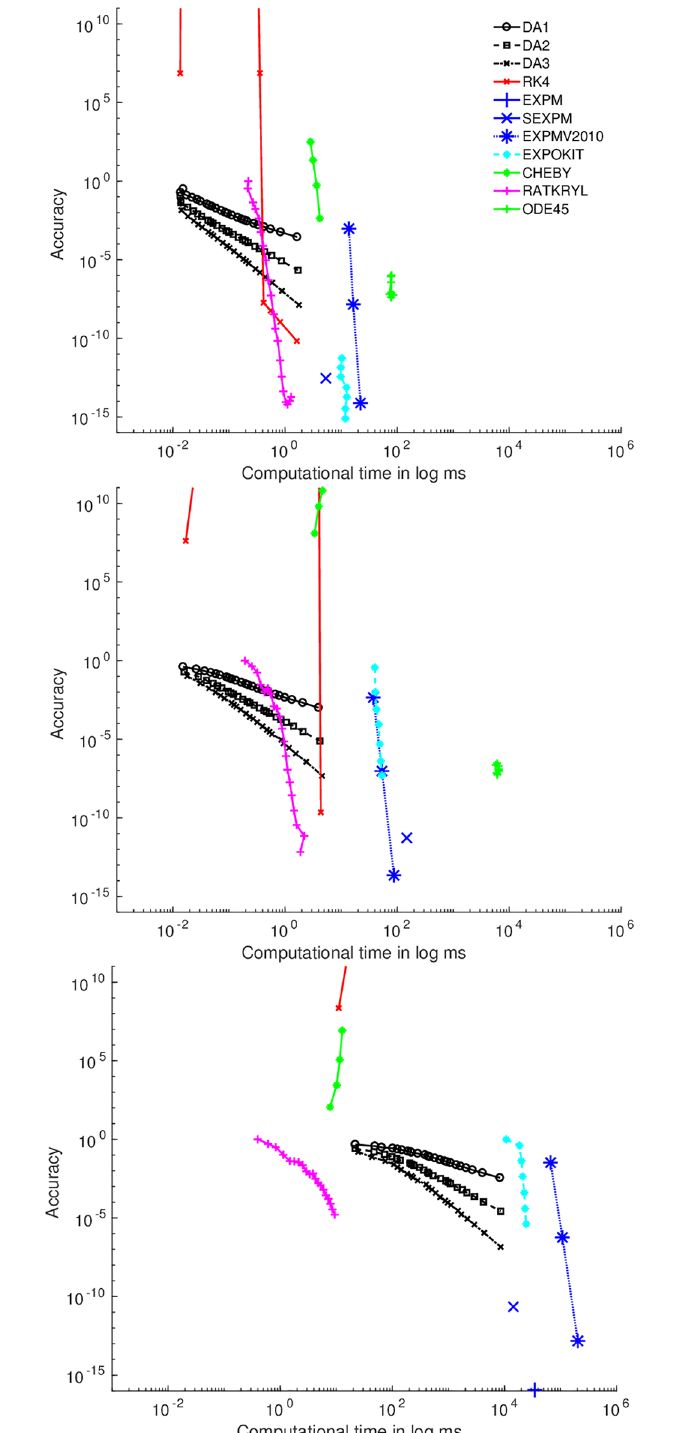
Fig 1. Computational time versus accuracy for a matrix of size 66 × 66 with N = 10 (top), 496 × 496 with N = 30 (middle) and 5,050 × 5,050 with N = 99 (bottom). The x-axis shows the computational time while the y-axis shows the accuracy, measured as ℓ 1 -norm between each of the algorithm’s results and the reference result (note that both are on a logarithmic scale).